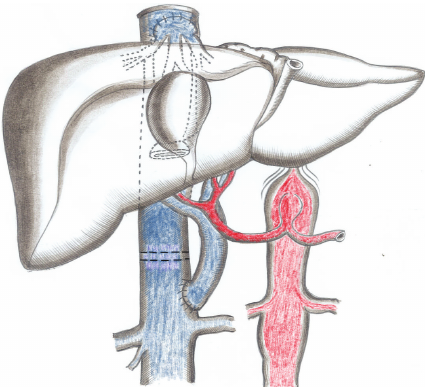
Figure 1: Side-to-end cavoportal hemitransposition with complete diversion oftheIVCflowtotheallograftand side-to-sidecavocavos- tomy.